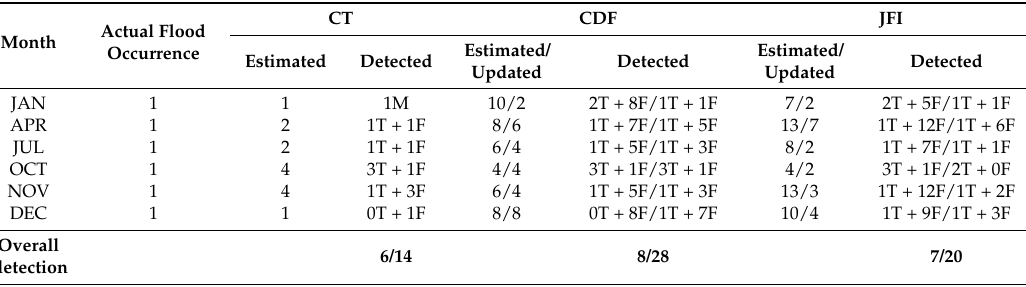
Table 6. Comparison of flood alarms after updating the